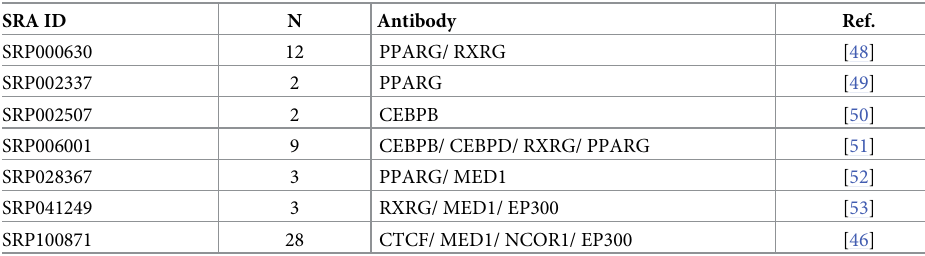
Table 2. Transcription factors binding data.